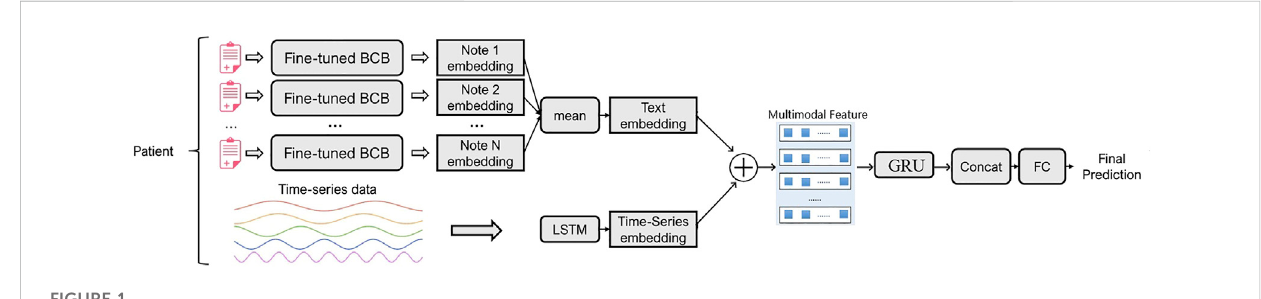
FIGURE 1 The overall architecture of the